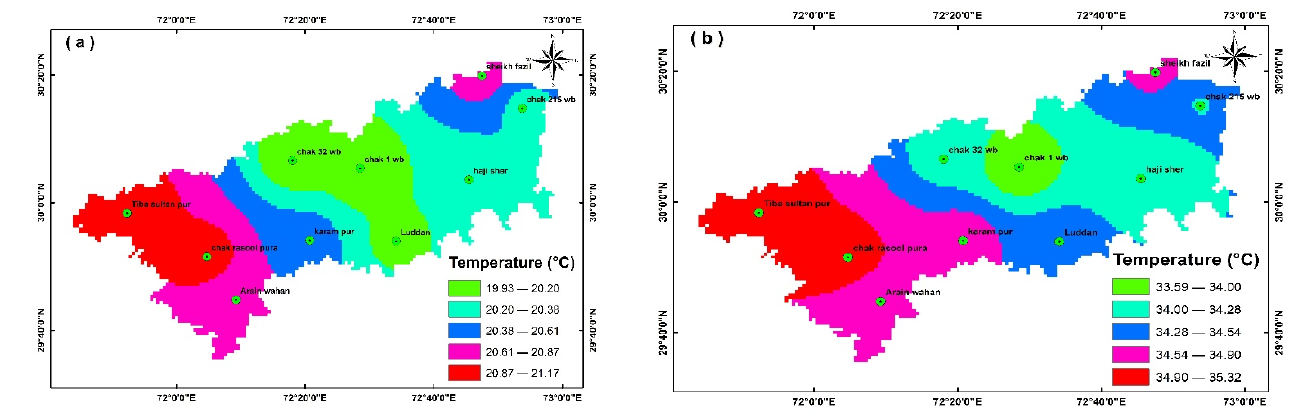
Figure 10. Maps of mean temperature during 1984 to 2020 ( a ) Rabi and ( b ) Kharif season.